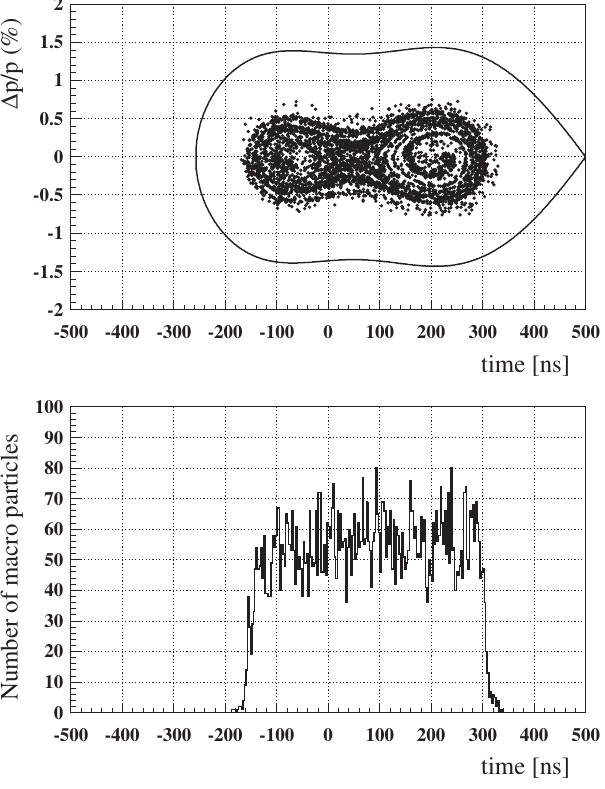
FIG. 1. A typical bunch shape after injection applying the second harmonic rf. The ratio of the second harmonic to the fundamental is